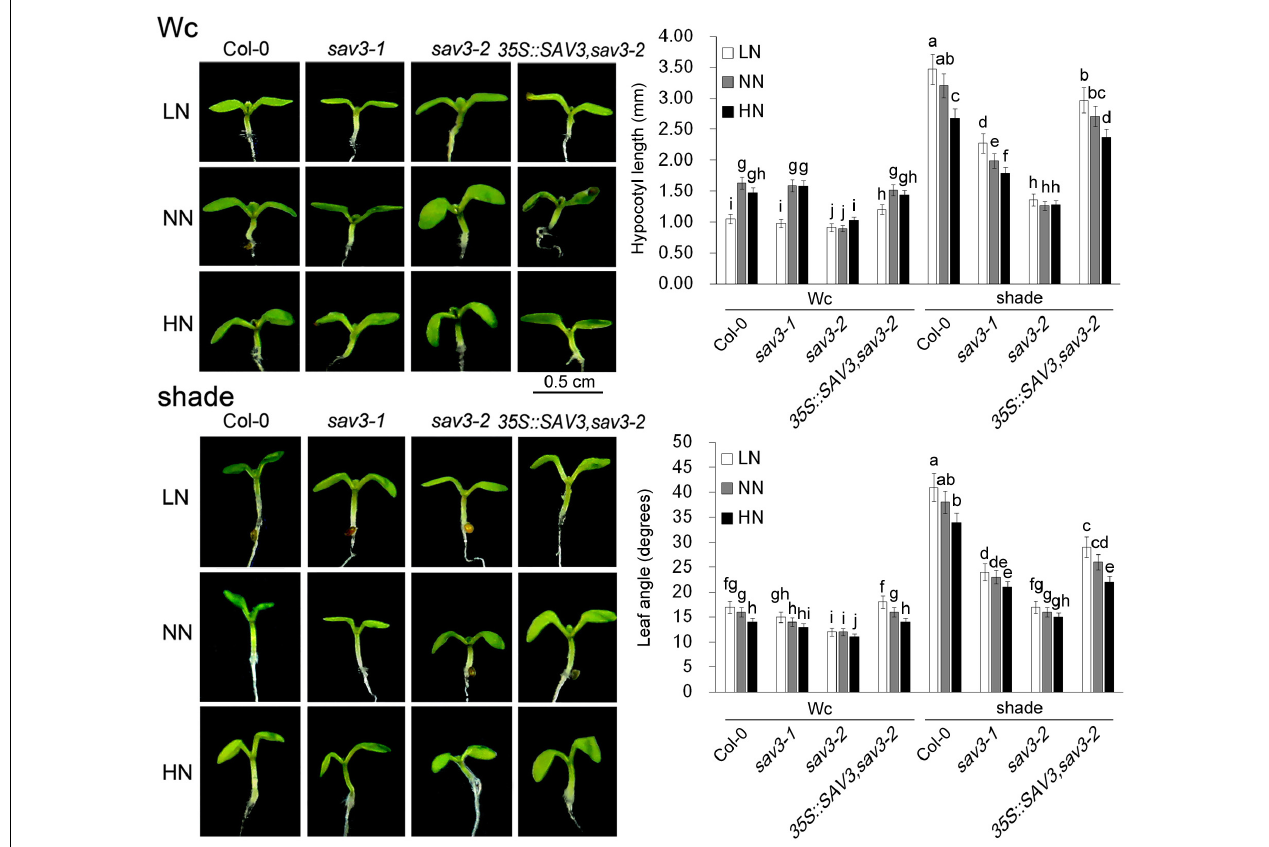
FIGURE 2 | Shade avoidance responses were reduced by high-N treatment. Hypocotyl lengths and leaf angles of 5-day-old seedlings under different N levels with or without shade treatment were recorded. Wc, continuous white light; LN, low N condition; NN, normal N condition; HN, high N condition. Phenotypes are shown in the left panel; quantitative data are shown in the right panel. Bars represent standard deviations of 15 independent replicates. Values followed by different letters are significantly different at P < 0.05 according to Duncan’s multiple range test.